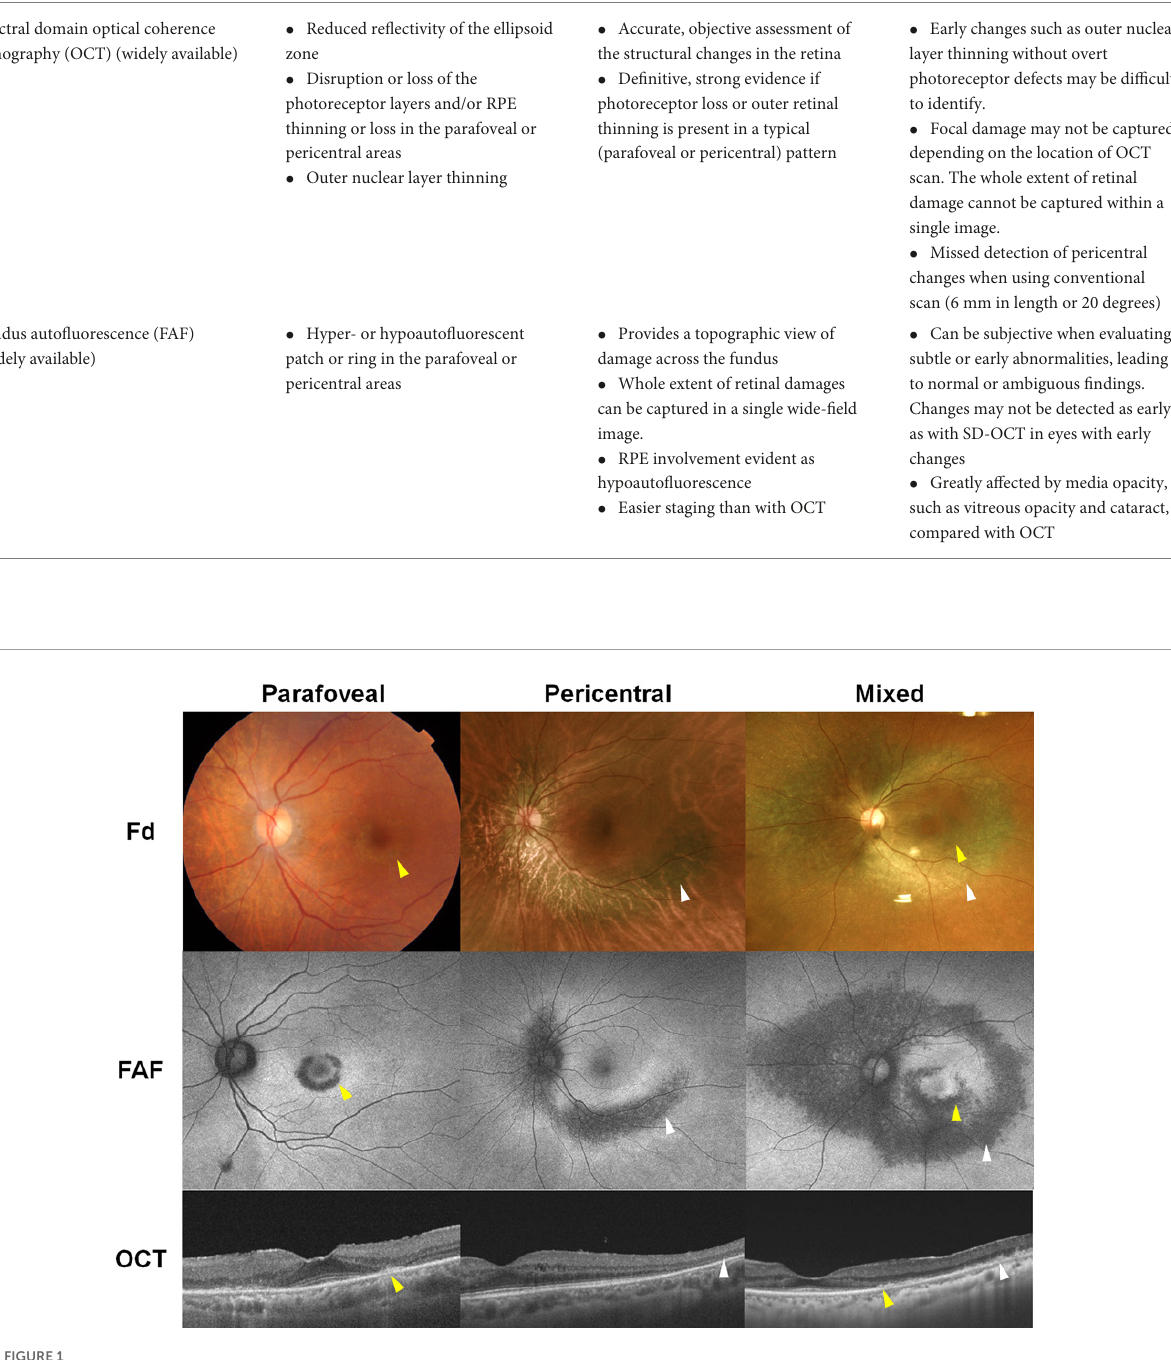
FIGURE1 Representative images of hydroxychloroquine retinopathy in patients treated with hydroxychloroquine therapy (left: 200 mg/day for 21 years, middle: 200 mg/day for 20 years, right: 200 mg/day for 20 years). These cases demonstrate parafoveal, pericentral, and mixed (both) involvement on fundus examination (Fd), fundus autofluorescence (FAF), and optical coherence tomography (OCT) images. Yellow and white arrowheads indicate parafoveal and pericentral retinal damage,